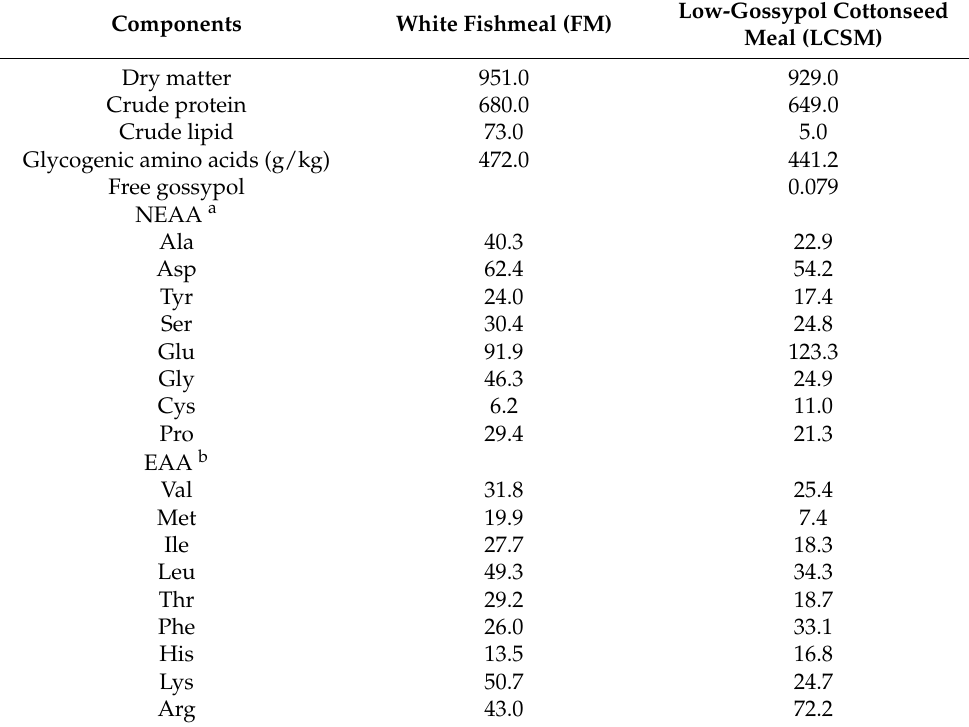
Table 1. Chemical composition of the test ingredients (g/kg dry matter).